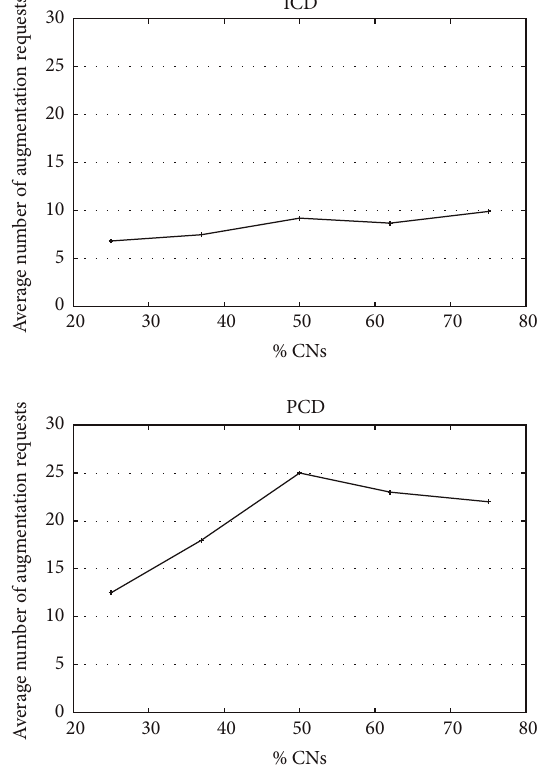
Figure 13: Average number of augmentation requests performed by AppNs in ICD and PCD against different ratios of CNs within the VANET.